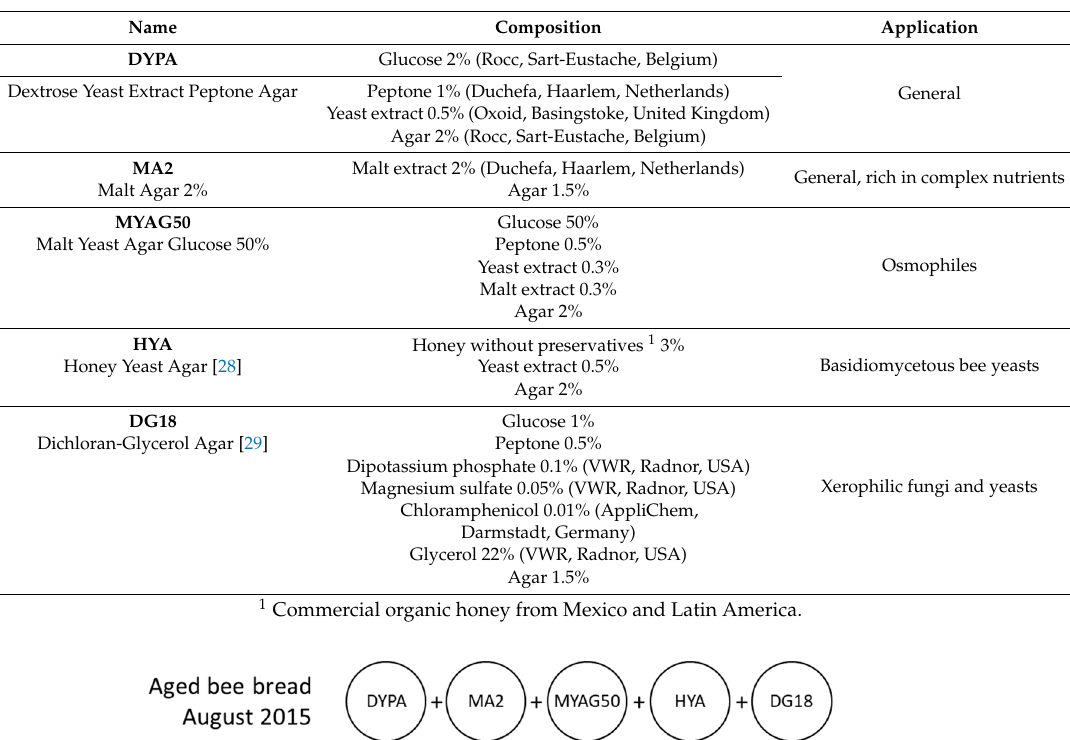
Table 1. Cultivation media.